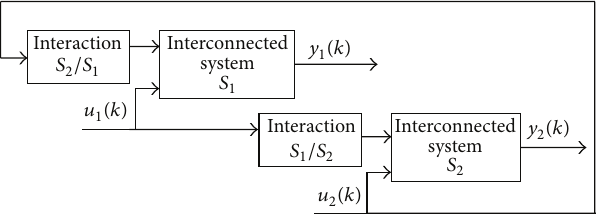
Figure 3: Interaction structure of the considered interconnected nonlinear subsystems 𝑆 1 and 𝑆 2